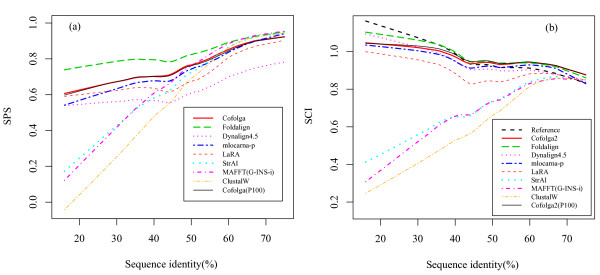
RNA alignment benchmark with the k2 dataset of BRAliBase 2.1. Alignment quality benchmark results for (a) sum-of-pair score (SPS) and (b) structure conservation index (SCI). The results for Cofolga2 with a population size = 50 and 100 are denoted by 'Cofolga' and 'Cofolga(P100)', respectively. The curves were drawn by lowess smoothing with a smoother span of 0.3.